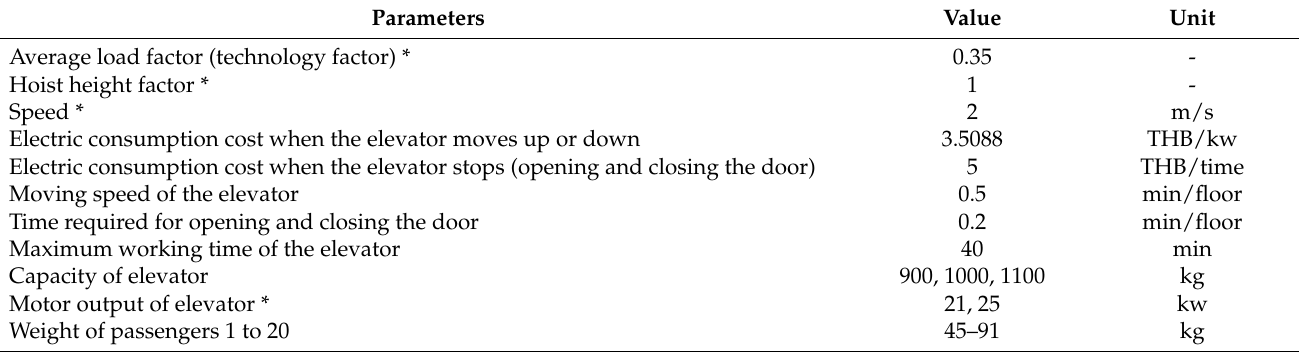
Table 1. Parameters used in the MINLP